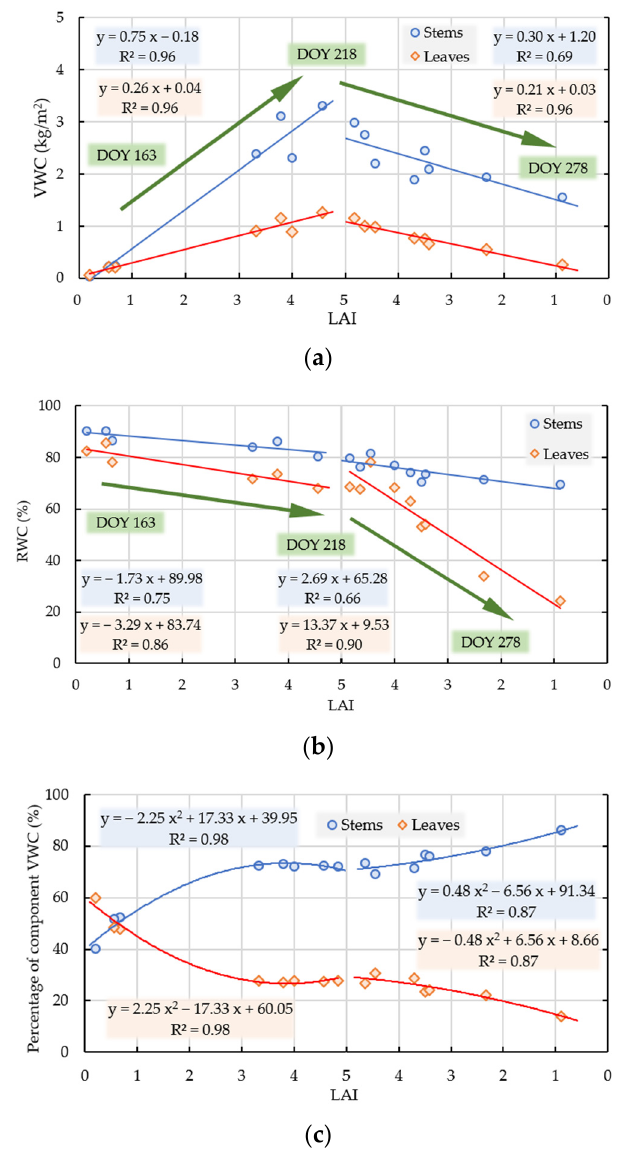
Figure 7. The allocation characteristics of the ( a ) VWC and ( b ) RWC, and ( c ) percentage relationships of the maize stem and leaf contributions to the VWC for the entire growing season.